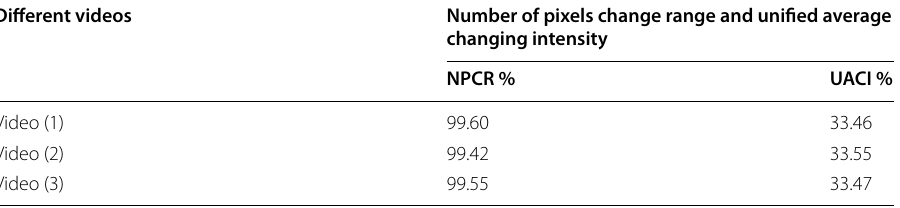
Table 5 Number of pixels change range and unified average changing intensity for I‑frames with different Keys